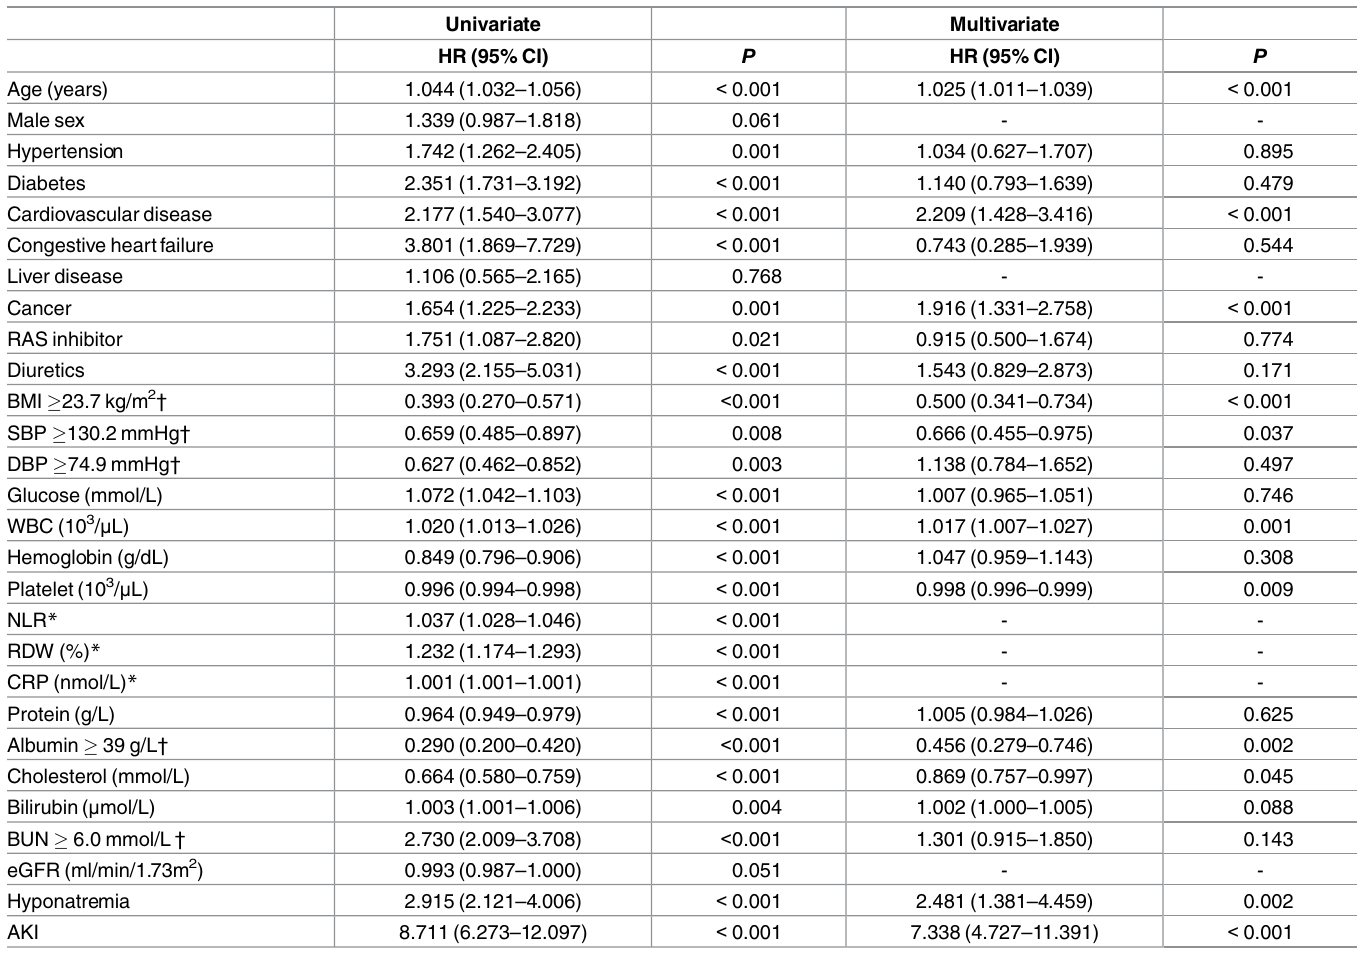
Table 3. Hazard ratiofor in-hospitalmortality in Cox proportional hazard